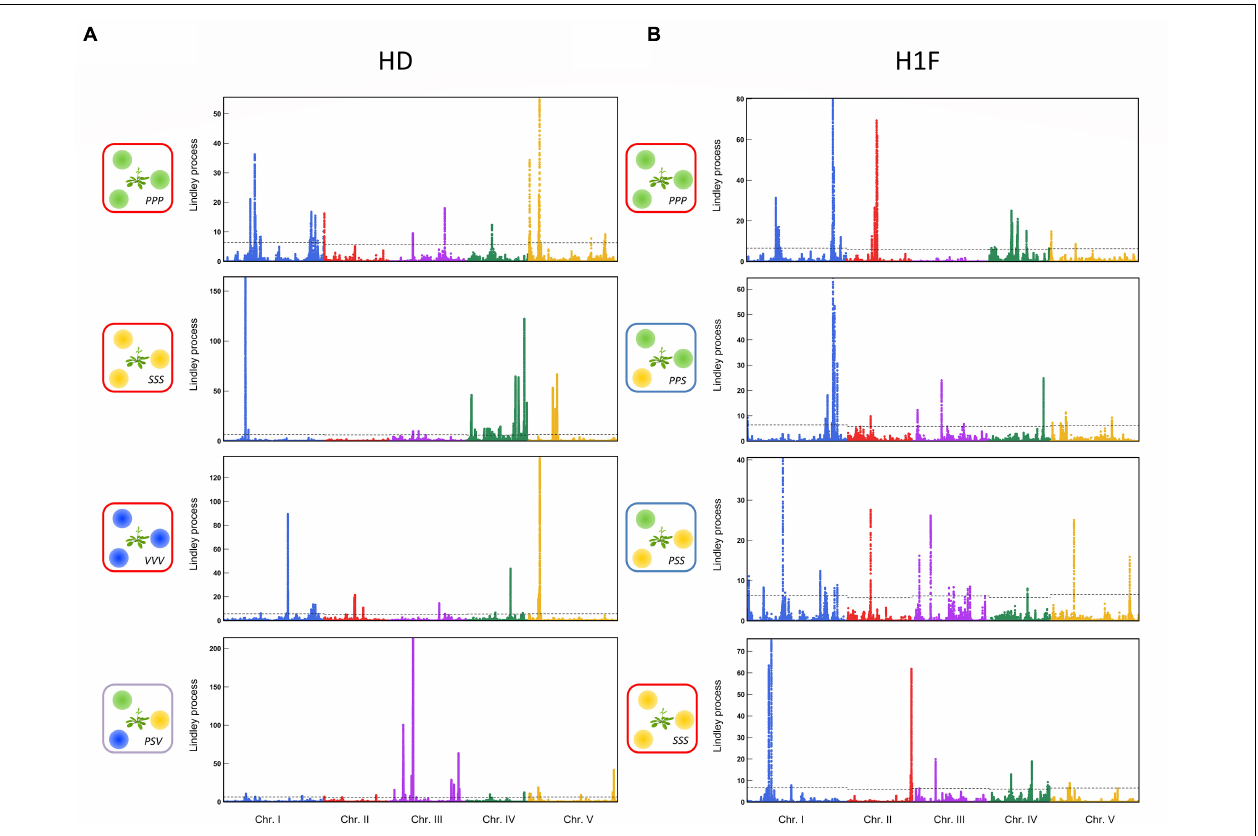
FIGURE 4 | Comparison of the genetic architecture of response of A. thaliana among bispecific and plurispecific neighborhoods in the TOU-A population. (A) Manhattan plots comparing the GWA mapping results for the bispecific PPP, SSS, and VVV treatments and the plurispecific interaction treatment PSV for the HD ratio. (B) Manhattan plots comparing the GWA mapping results from the bispecific PPP to SSS treatments (PPP → PPS → PSS → SSS) for the H1F trait. The x -axis indicates the physical position of the 630,234 SNPs along the five chromosomes. The y -axis indicates the Lindley process scores estimated from -log 10 p -values from the mixed model implemented in the software genome-wide efficient mixed model association (GEMMA) using SNPs with a minor allele relative frequency (MARF) >